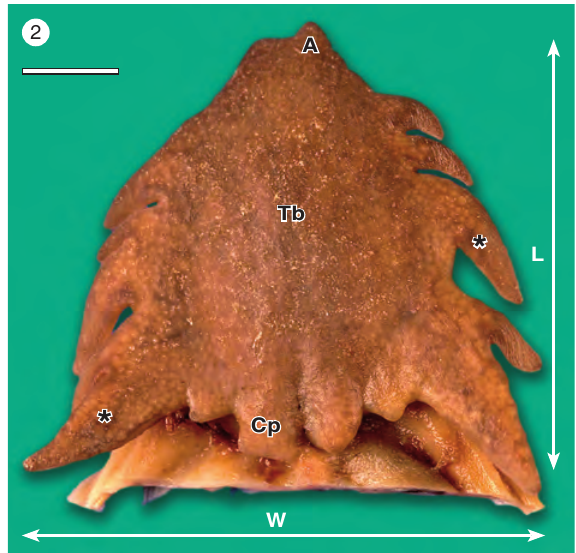
FIG. 2 Dorsal view of the tongue body (Tb) showing the apex (A), lateral lingual papillae (*) and caudal lingual papillae (Cp). Tongue body length (L) was measured from the apex to the caudal papillae. The width (W) was measured between the tips of the last lateral papillae. Bar =